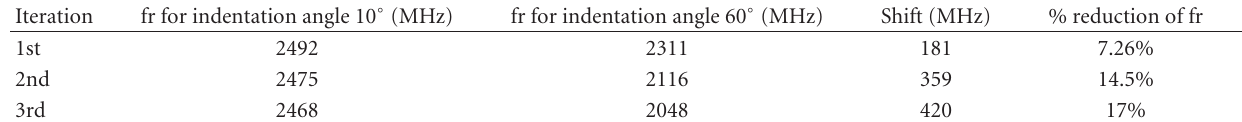
Table 2: Percentage reduction of resonant frequency with iteration and indentation angles.